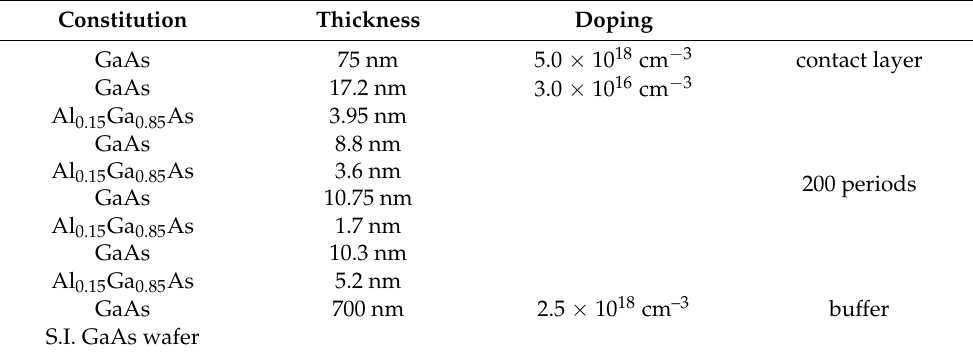
Table 1. Structural parameters of GaAs/AlGaAs THz QCLs.